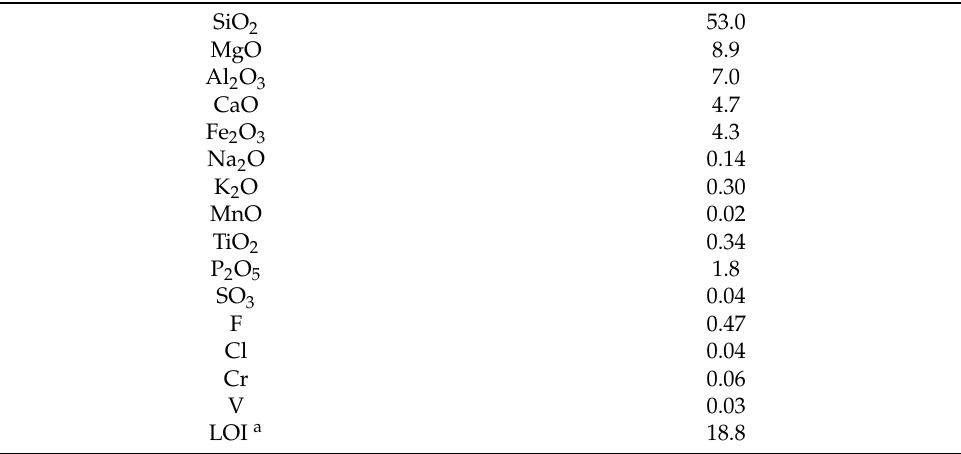
Table 1. WDXRF data (in wt %) of the